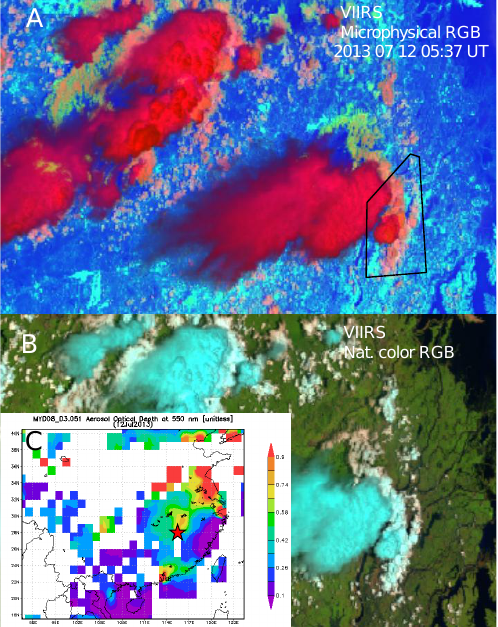
Fig. 21. Deep convection in haze of air pollution over southeast China, as seen by the VIIRS overpasses on 12 July 2013 05:37UT in an area of 200km × 106km centered at 28.74 ◦ N, 115.32 ◦ E. The pollution haze is shown in panel (C) as the MODIS retrieved map of aerosol optical depth (AOD). The red star shows the location of the cloud marked by the rectangle in panel (A) ; it is located at an area with AOD =